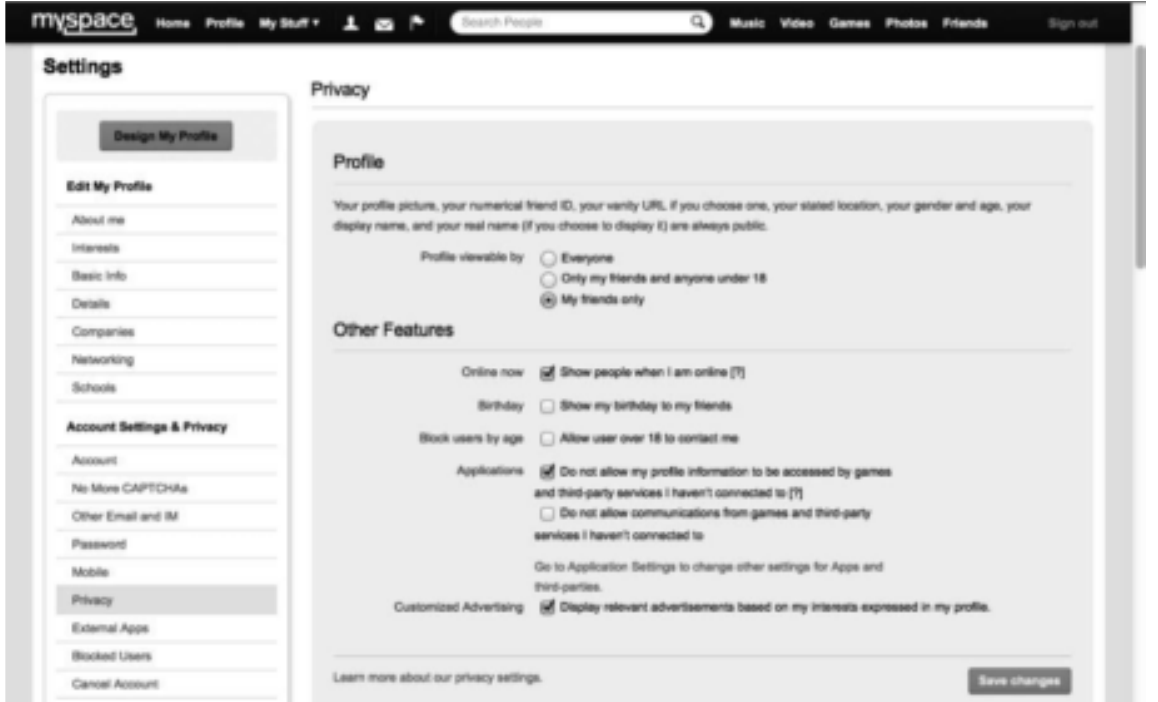
Figure 2. Available privacy options in account